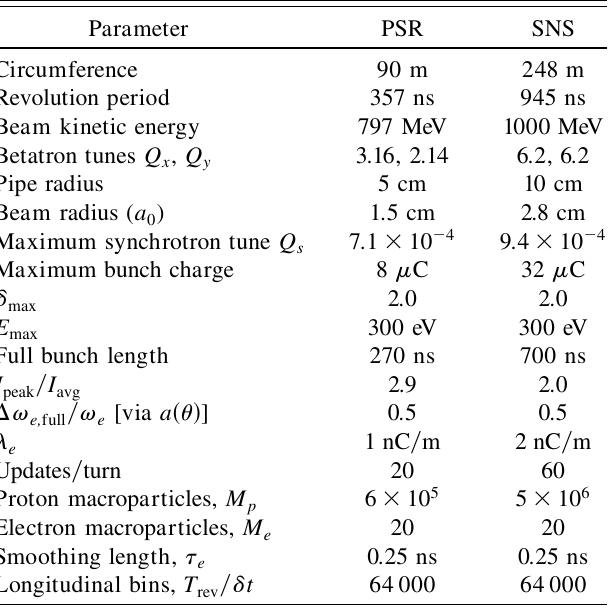
TABLE IV. Nominal simulation parameters for the PSR and